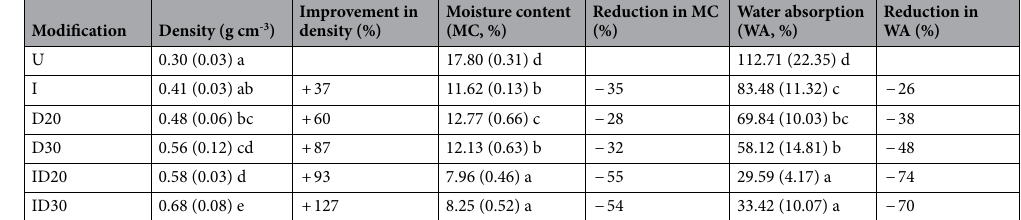
Table 5. Density, moisture content, and water absorption of modified inner part of oil palm trunk. Notes: Values in parentheses are standard deviations. U = Untreated; I = Impregnation; D20 and D30 = densification with compression ratio (CR) 20% and 30%, respectively; ID20 and ID 30 = compregnation with CR 20% and 30%, respectively. Different letters in the same column indicate significant differences at the 5% level of significance based on Duncan’s multiple range